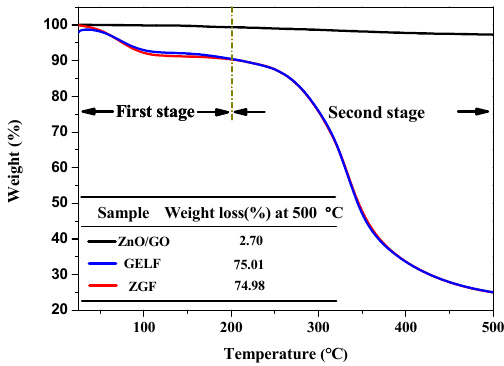
Figure 7. TGA curves of ZnO/GO, GELF and ZGF.